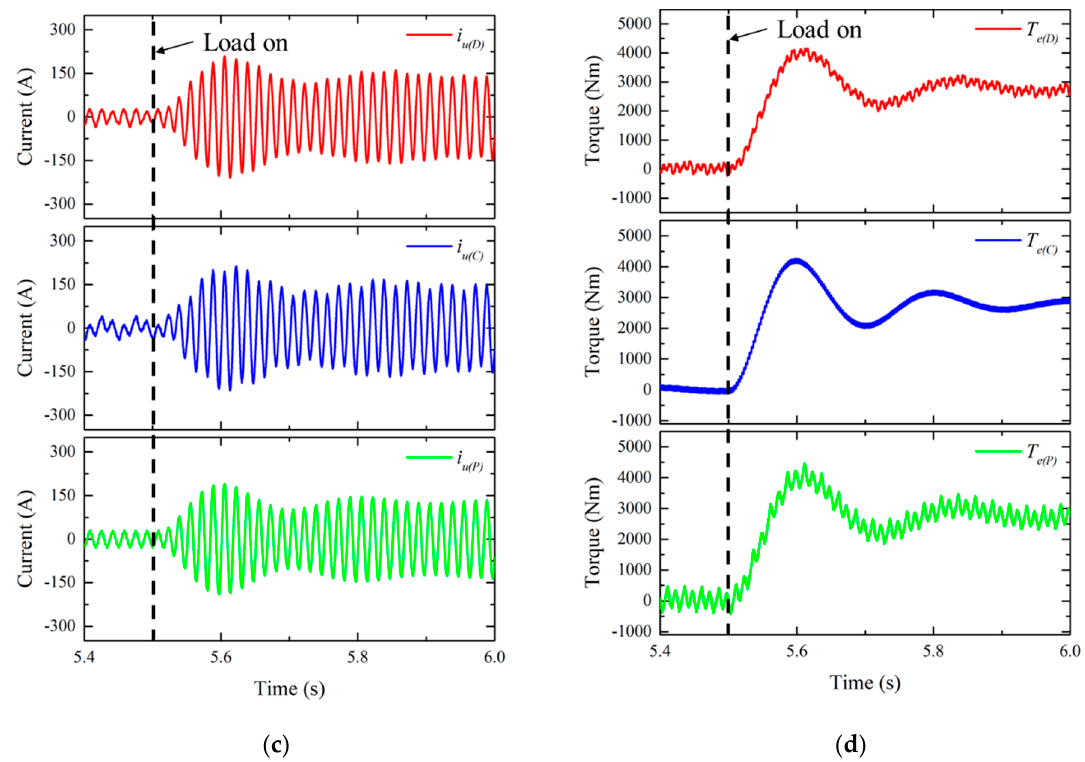
Figure 4. Comparison of dynamic characteristics at rated speed and rated load torque. ( a ) Phase u voltage; ( b ) Motor Speed; ( c ) Phase u currents; ( d ) Output Torque